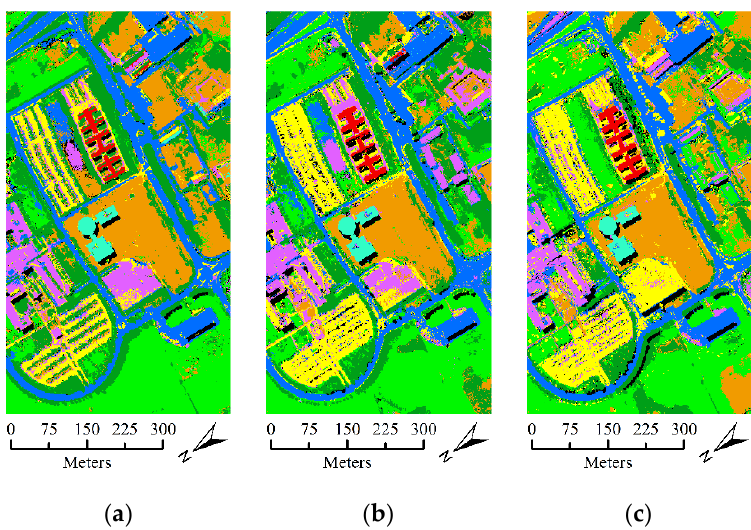
Figure 10. Classification maps of Pavia University dataset obtained by using different spatial neighborhood information: ( a ) SA (92.69%); ( b ) SP (88.92%); and, ( c ) FS (90.41%).